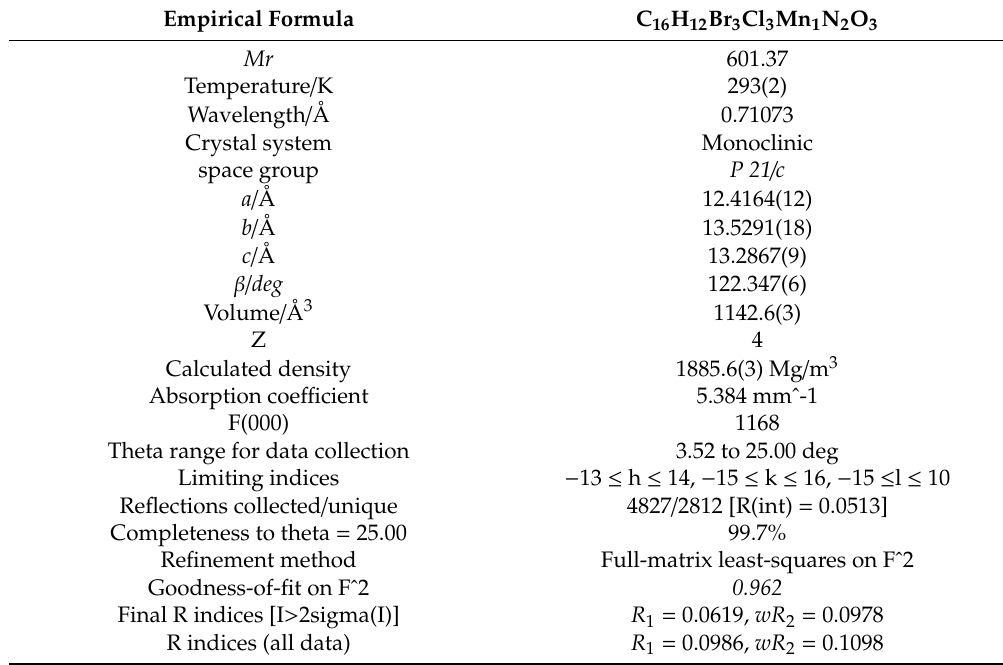
Table 1. Crystal data and details of structural determination and refinement for 1. Empirical